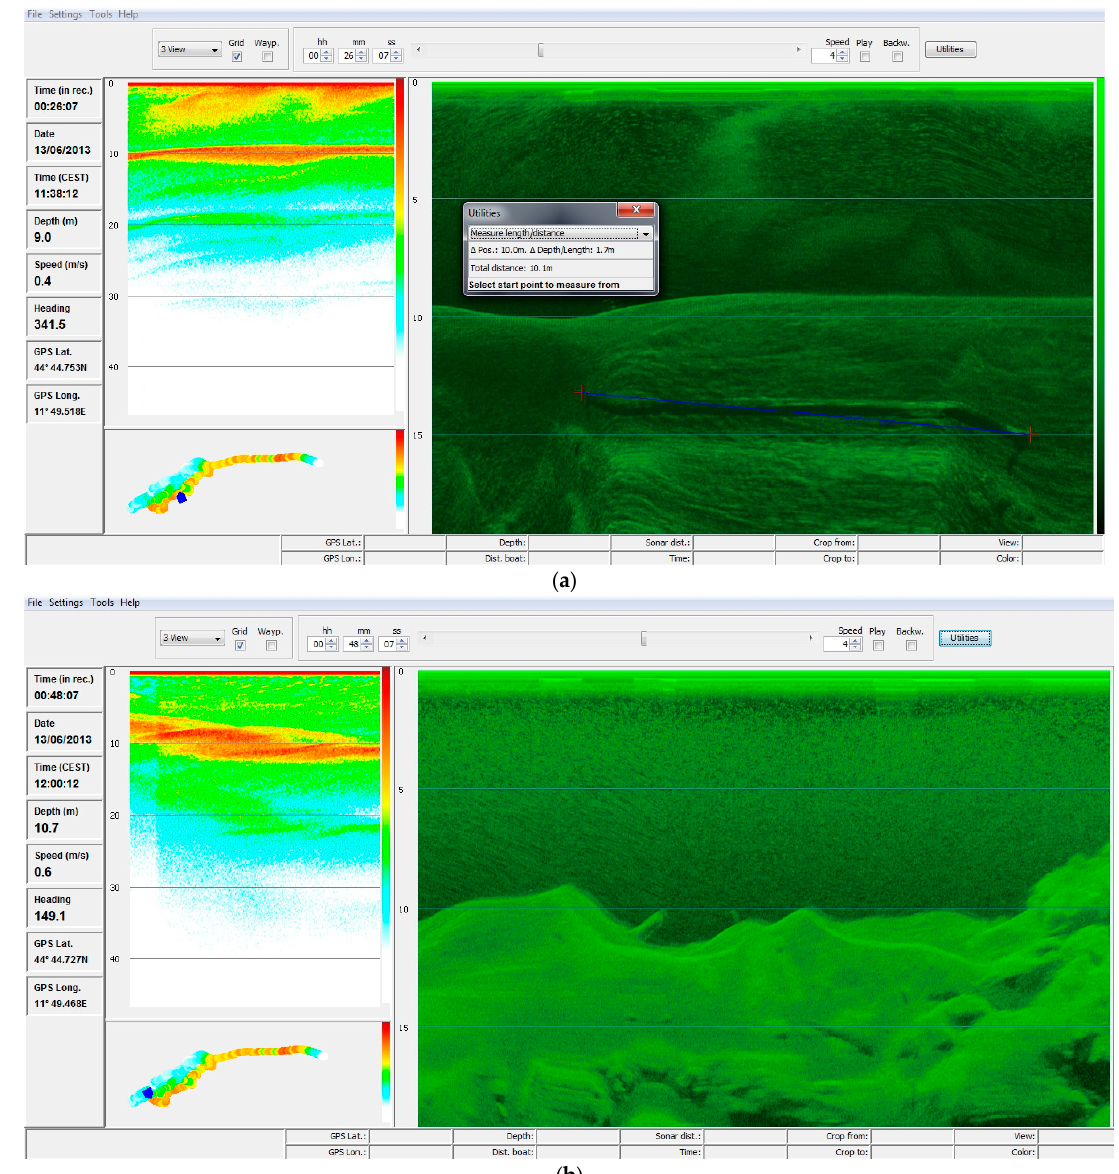
Figure 7. Visualization of the echo side scan sonar snap shots with Hum viewer software, in Lago Tramonto, Gambulaga, Portomaggiore (FE, Italy): ( a ) Bottom, down image and position with metrical reference of a big trunk; ( b ) Bottom, down image and position of anthropic traces. A tiny current could still be detected in the alveo because of the natural course of the falda water, following the morphology of the ancient hydrographical context.